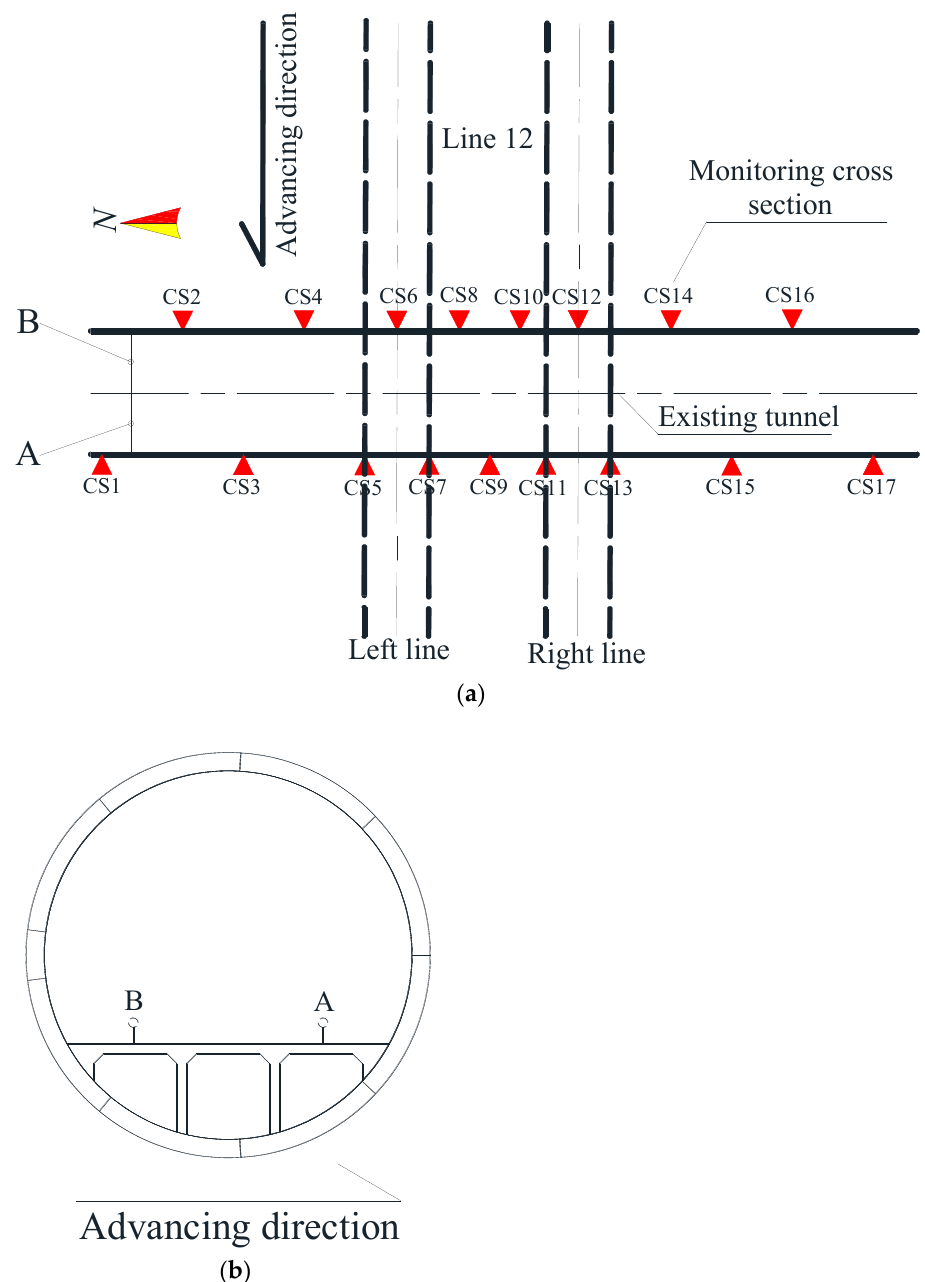
Figure 6. ( a ) Plane layout of the monitoring section along the existing large-diameter tunnel and ( b ) layout of the monitoring points.